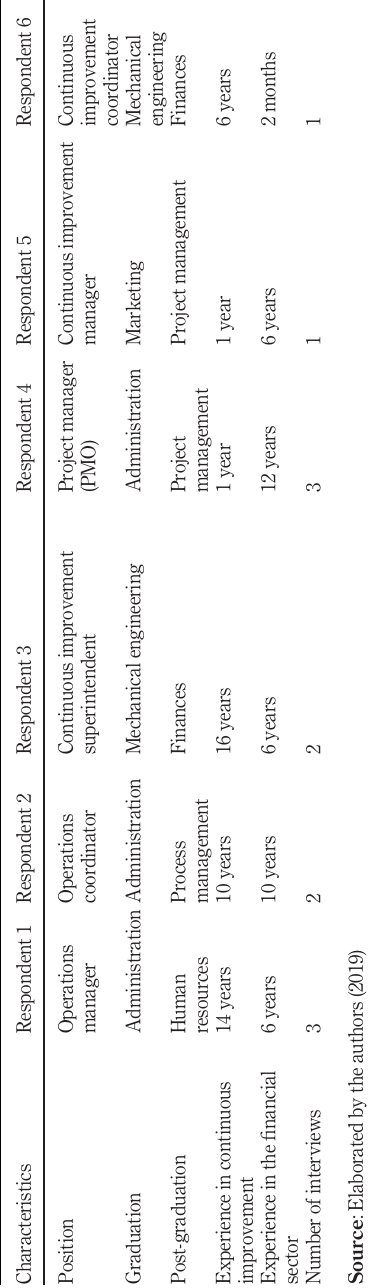
Table 1. Characteristics